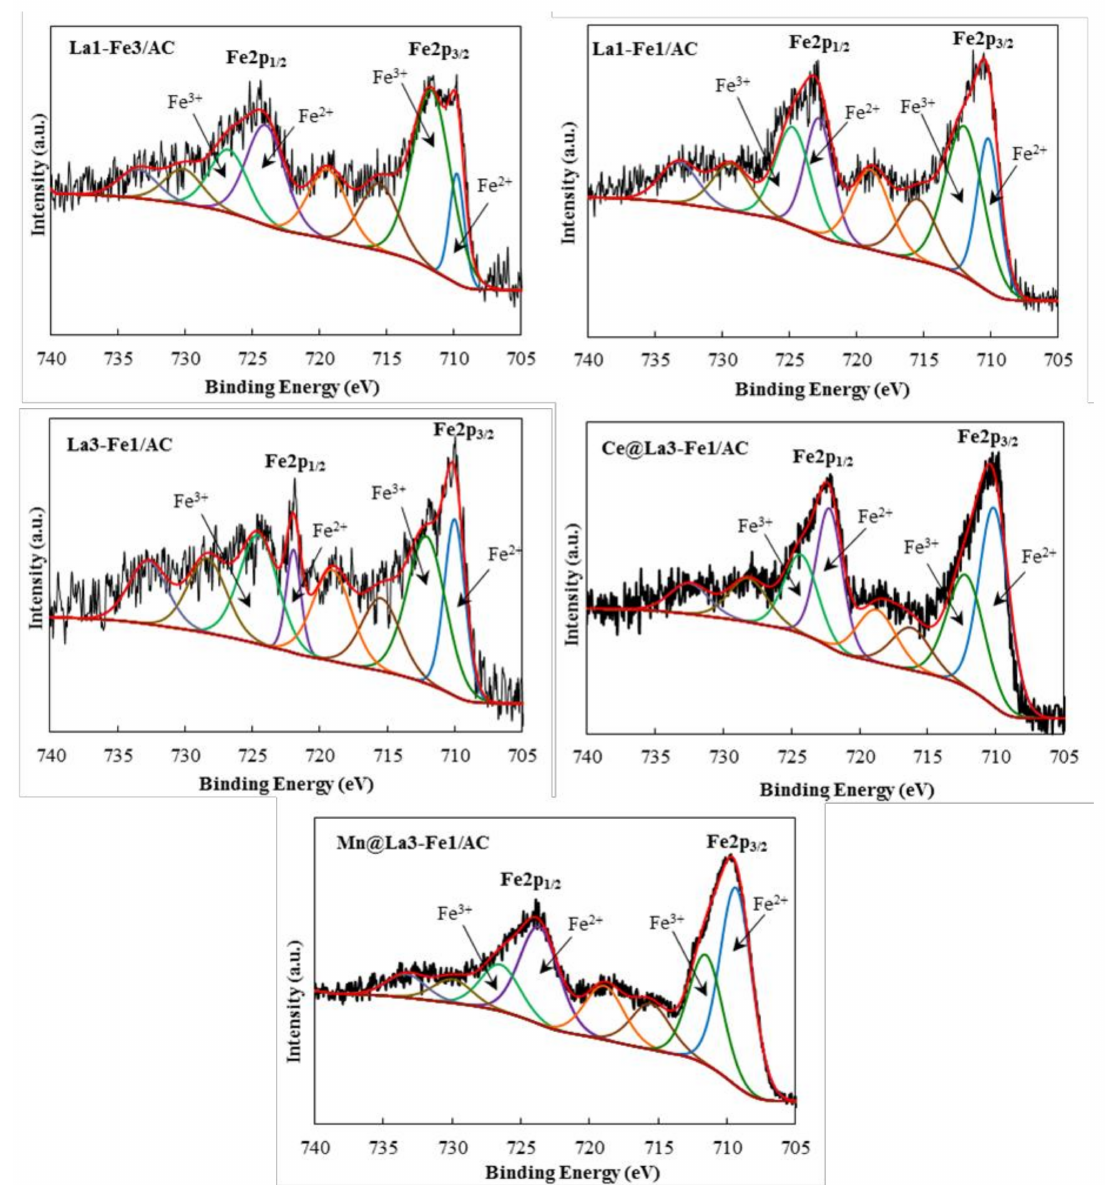
Figure 4. XPS spectrum of Fe2p of the synthesized catalysts La1-Fe3 / AC, La1-Fe1 / AC, La3-Fe1 / AC, Ce@La3-Fe1 / AC, and Mn@La3-Fe1 /